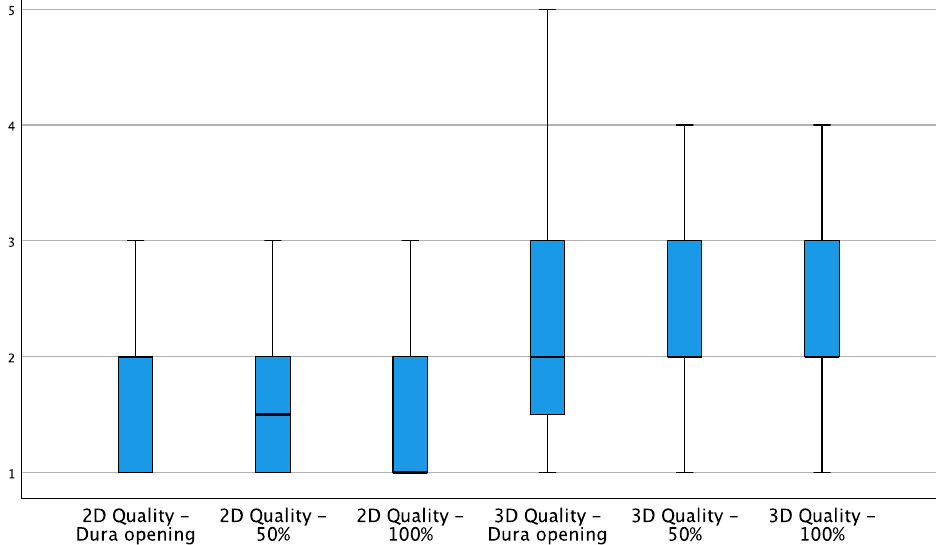
Figure 3. Box plot showing 2D and 3D quality variations during the different stages of resection.